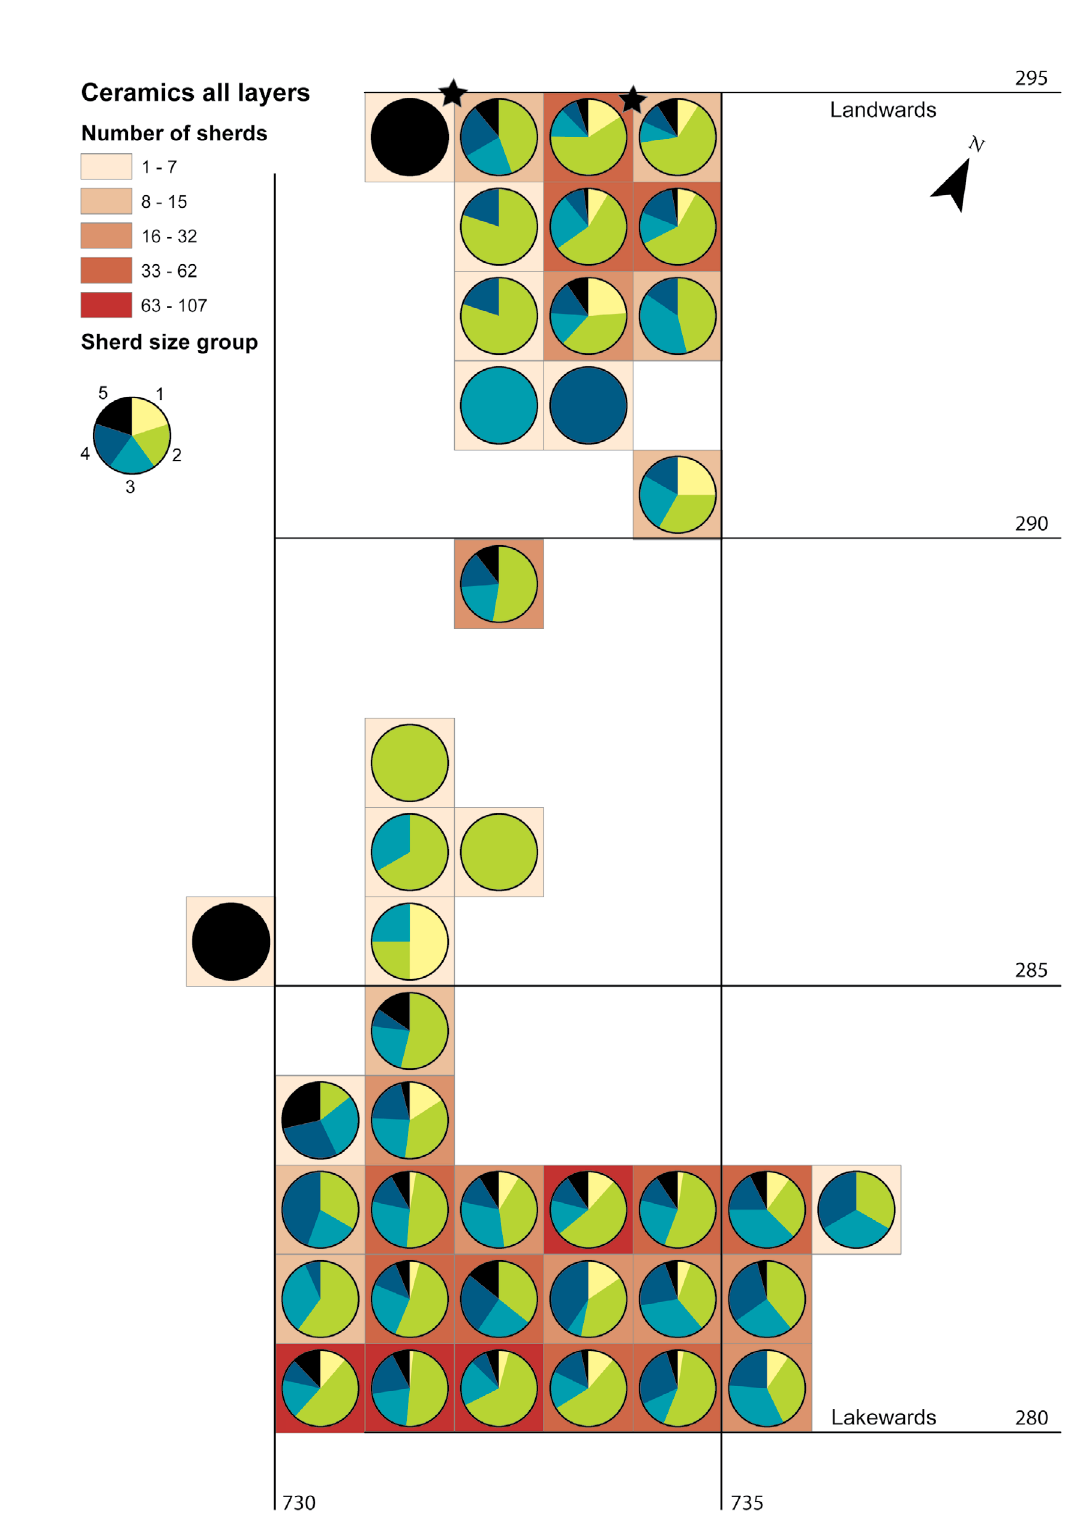
Figure 3. Count of sherds per layer (red background) and size of sherd (1 = 1 – 2 cm 2 , 2 = 3 – 10; 3 = 11 – 19; 4 = 20 – 49; 5 = > 49) per excavated grid square. Approximate sample locations used by Wiemann et al. 2012 marked with star. Grid lines relate to co-ordinate system set out during excavation (Künzler Wagner